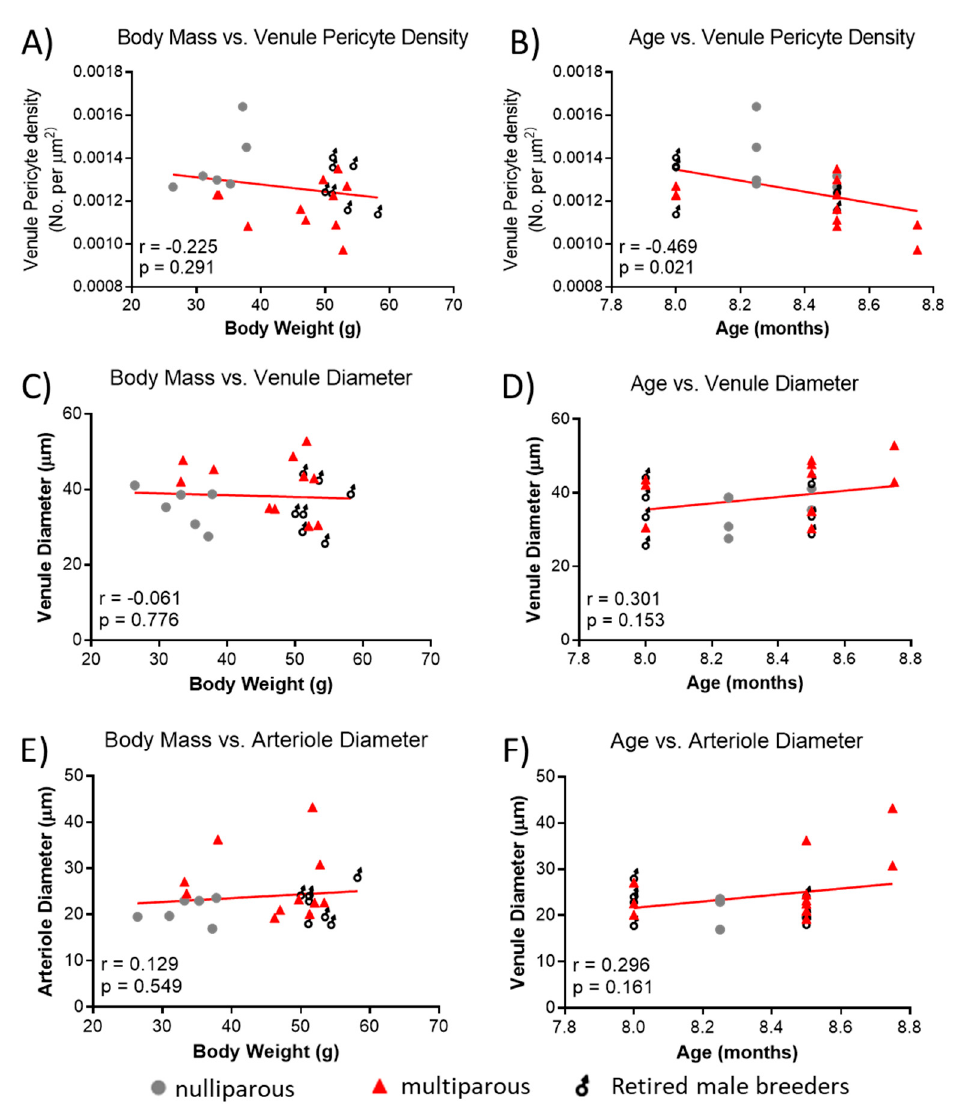
Figure 4. Relationship between body mass, age and retinal vascular parameters. ( A ) Association between body mass and retinal venule pericyte density. ( B ) Age vs. retinal venule pericyte density, ( C ) body mass vs. retinal arteriolar diameter, ( D ) age vs. venule diameter, ( E ) body mass vs. arteriole diameter, and ( F ) age vs. arteriole diameter. Mean values per mouse are shown by individual points. n = 6–11 per group. Lines were generated using linear regression. Pearson correlation was used for associations.